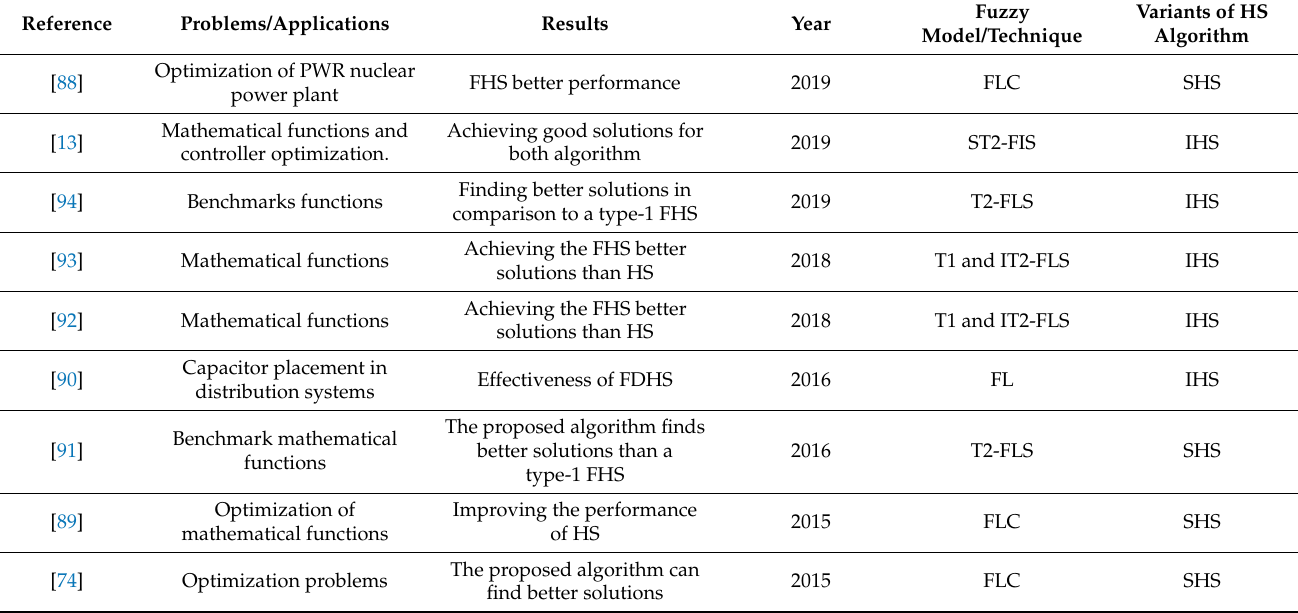
Table 2. A summary of the fuzzy HS algorithm-based